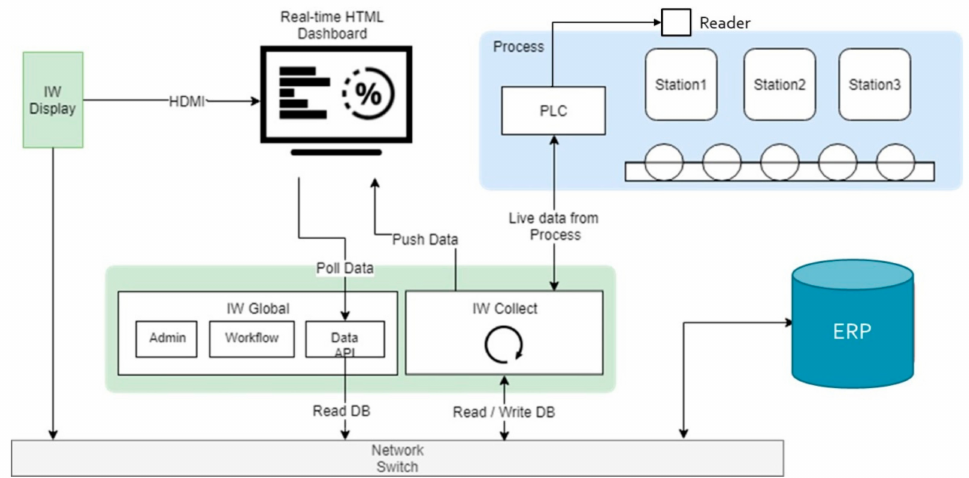
Figure 2. Industreweb™ 4.0 Edge Factory Connector